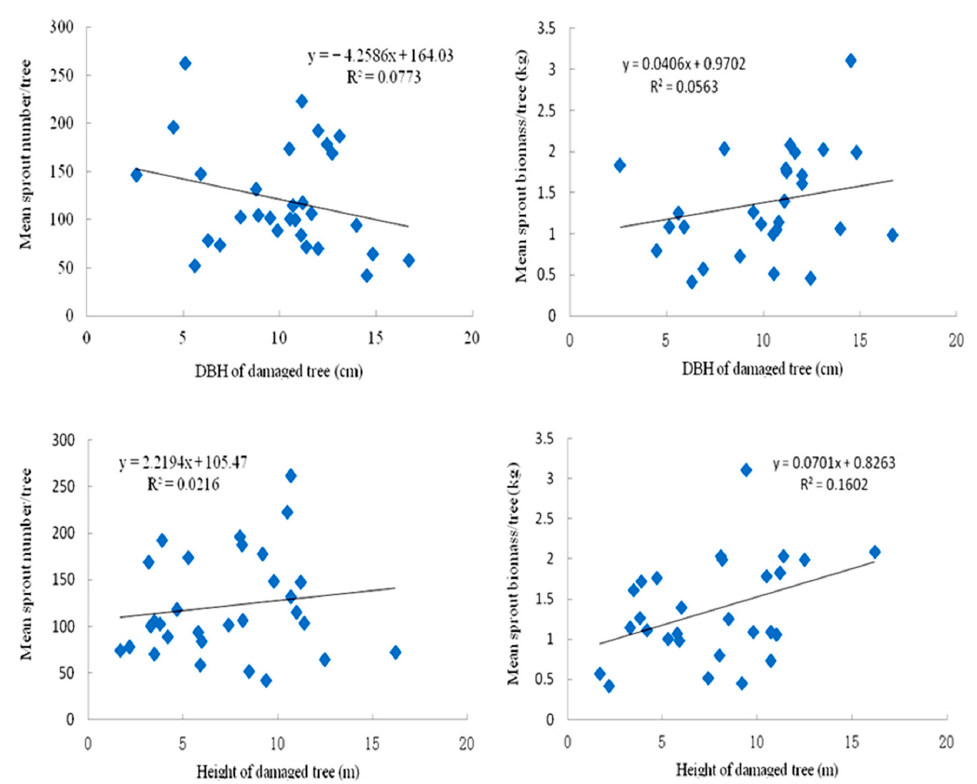
Figure 12. Regression analyses of diameter at breast height and height of sampled damaged tree on the sprout number / tree of all damaged types of trees in the 2009 year.